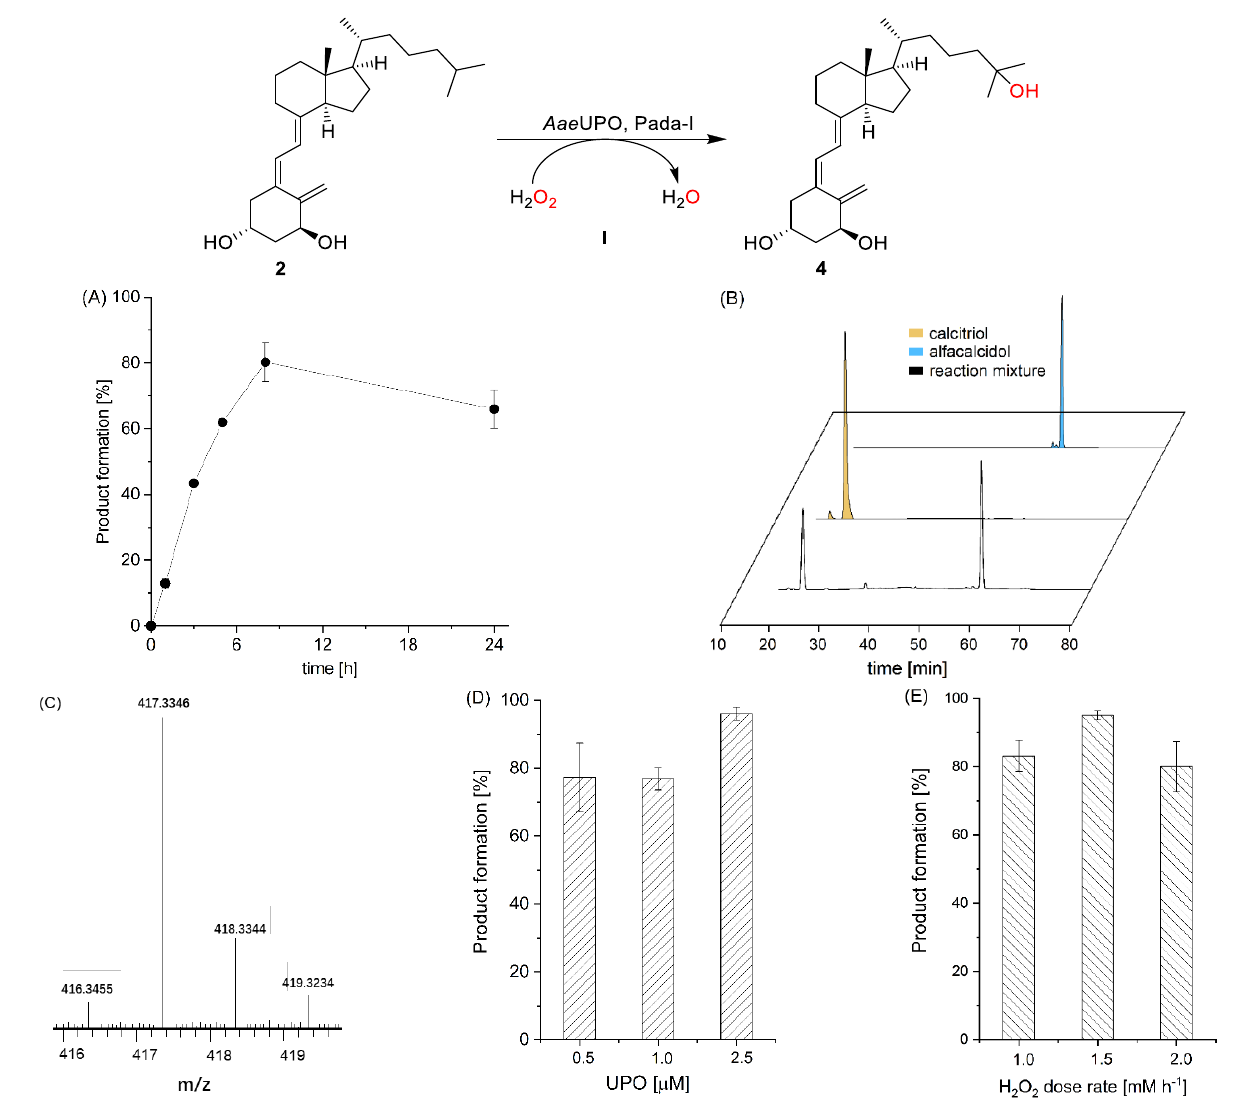
Figure 2. Aae UPO (Pada − I) catalyzed oxyfunctionalization of alfacalcidol to calcitriol (path I). Conditions: ( A ) [ Aae UPO] = 0.5 µ M, [substrate] = 2.5 mM, NaPi buffer (50 mM, pH 6), 40% ( v / v ) acetone, [H 2 O 2 ] = 1.0 mM h − 1 , 24 h, 25 ◦ C, 1 mL; ( B ) HPLC chromatograms of reaction solution and standard (small peaks in the standards indicate some impurities); ( C ) LC–MS chart of product calcitriol with mass spectrum displayed in [M + H] + ; ( D ) conditions: [ Aae UPO] = 0.5–2.5 µ